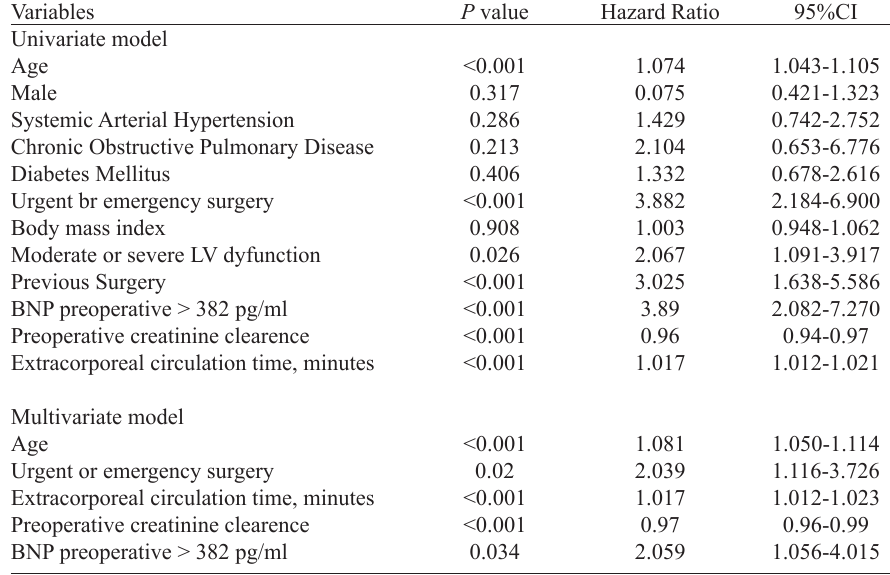
Table 2. Uni and multivariate analysis of the variables in relation to